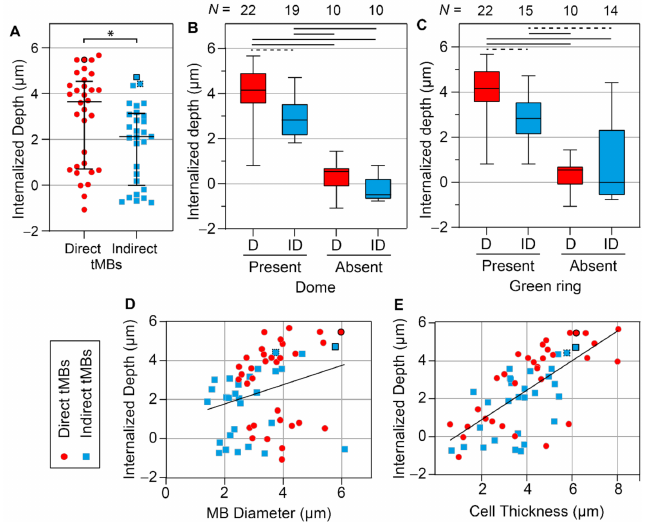
Figure 7. Internalization of targeted microbubbles (tMBs) bound to a HUVEC monolayer in static conditions with direct (circles) in red and indirect (squares) in blue. ( A ) Internalized depth ( µ m) of direct ( N = 32) versus indirect ( N = 29) targeted microbubbles with median and IQR. Significance is indicated with * p < 0.05. ( B , C ) Internalized depth of direct ( D , red) and indirect (ID, blue) bound microbubbles with ( B ) dome or ( C ) green ring present or absent in the CellMask Green channel, shown as boxplot with whiskers from min to max and N numbers listed above the graphs. Statistics are indicated with a solid black line for p < 0.001 and a dashed line for p < 0.01. ( D ) Internalized depth as a function of microbubble diameter. ( E ) Internalized depth as a function of cell thickness. In ( A , D , F ) the examples from Figure 6 are marked with: F6A) black circle, F6B) black square, and F6C) dotted black